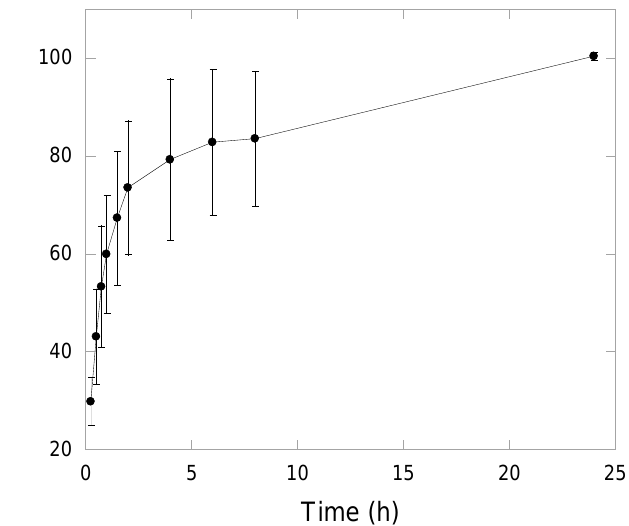
Figure 4. Berberine release profile from nanogels (NG6L formulation) recorded in saline solution using dialysis membranes setup (n = 3, mean ± sd).